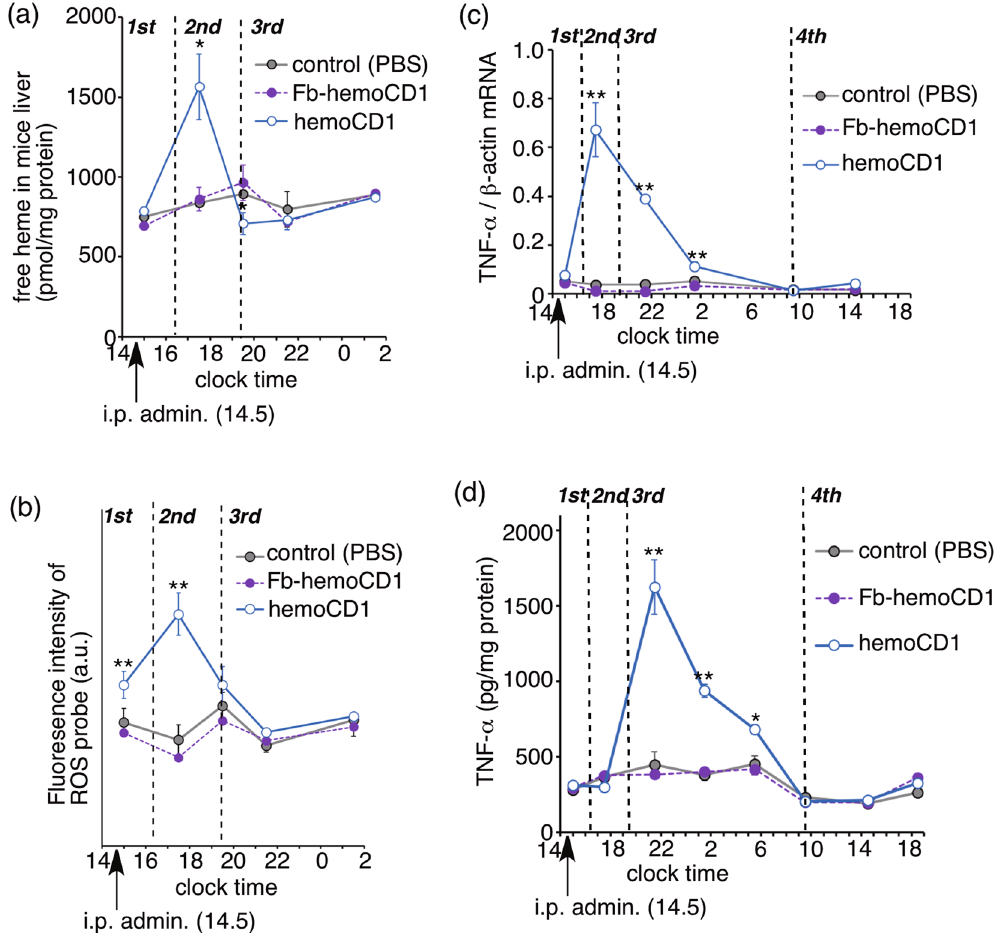
Figure 6. Changes in the amounts of free heme ( a ), ROS ( b ), and TNF- α (mRNA, ( c ); protein, ( d )) in the liver of hemoCD1-treated mice. PBS and Fb-hemoCD1 were similarly administered as controls. Each bar represents the mean ± SE ( n = 3 mice per group). Asterisk denotes statistical significance ( * P < 0.05, ** P < 0.01), as compared to the